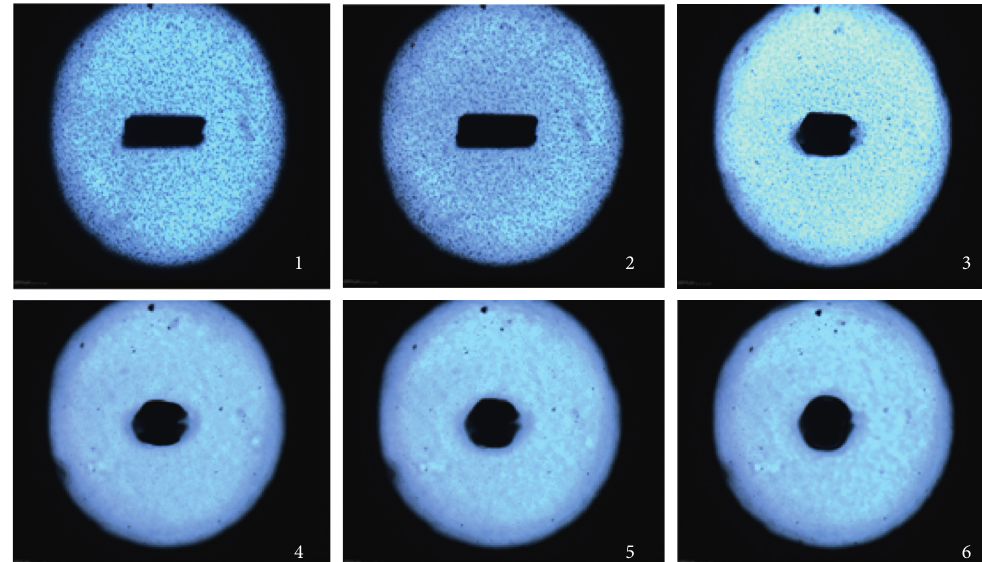
Figure 9: SEM image of the retraction process of PP short fiber in POE matrix.